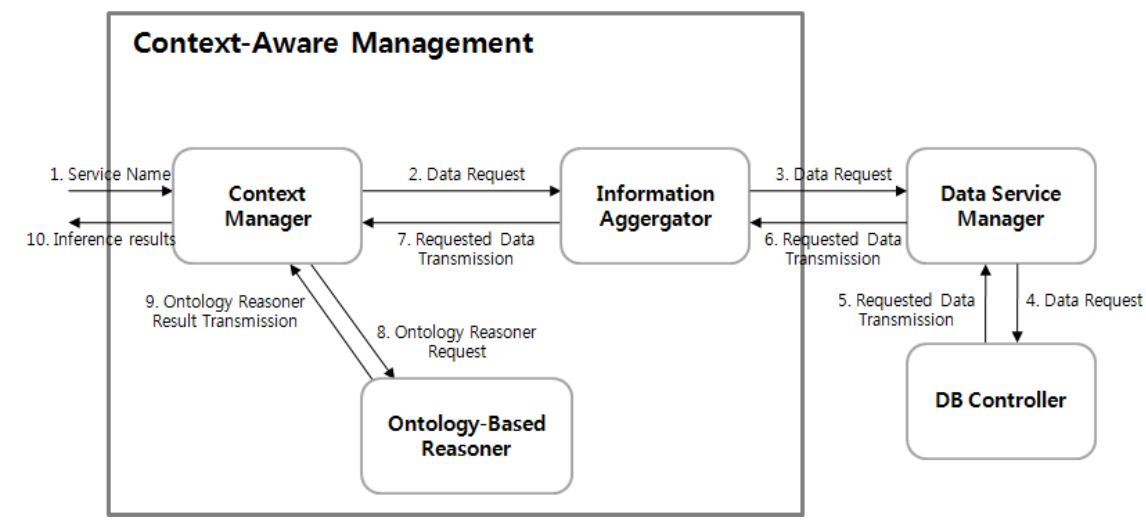
Figure 12. Structure and working process of the context aware management